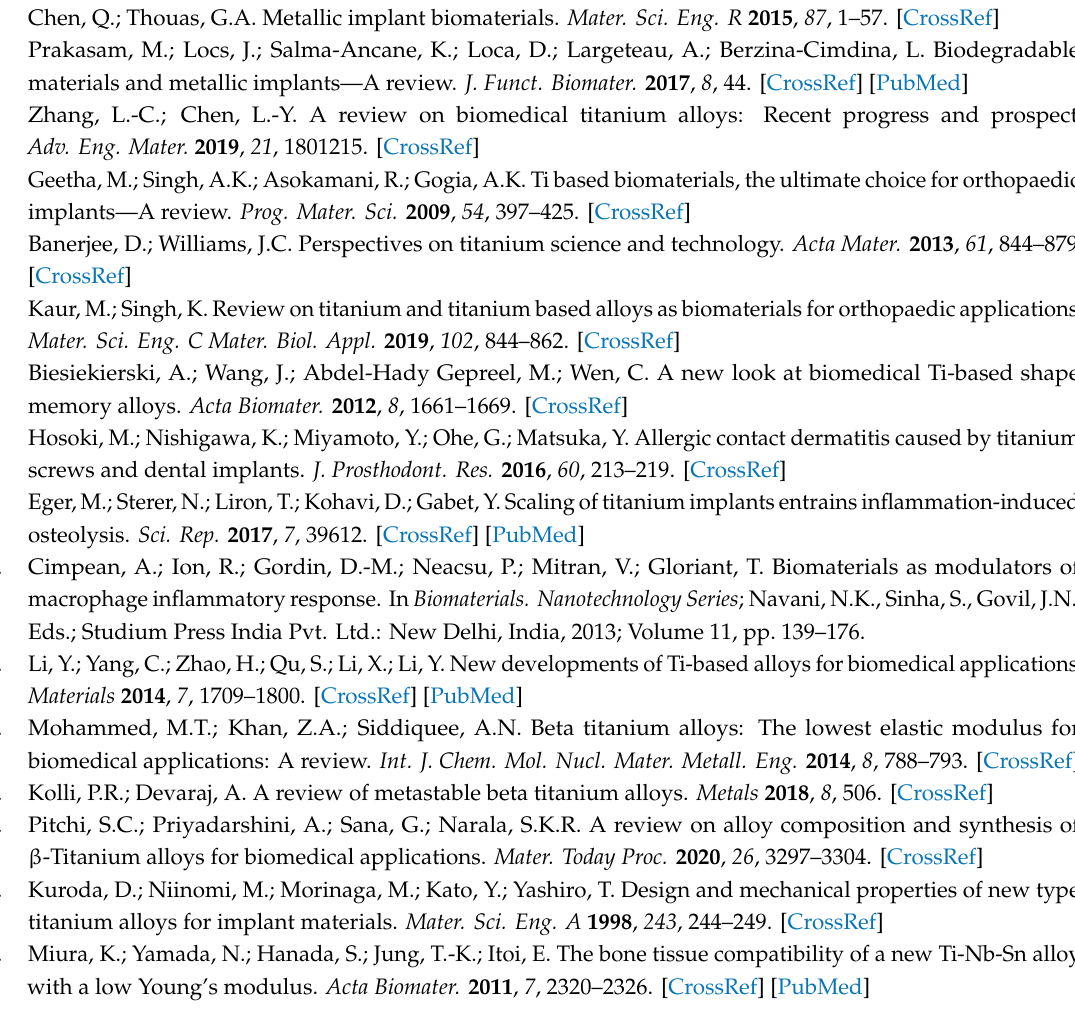
Figure S1: SEM-EDX point analysis of the as-cast sample: point 1-dark area and point 2-bright area of dendritic structure; Figure S2: Line scan by EDX across the full thickness of the as-cast sample highlighting the variation of its chemical